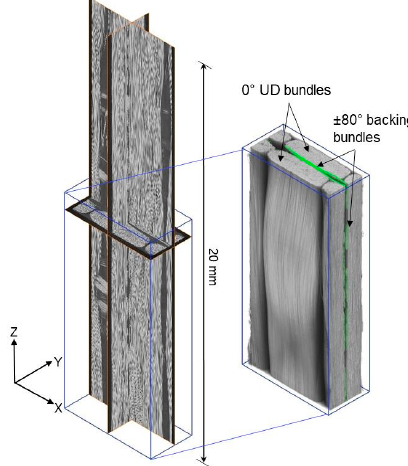
Figure 1. Orthogonal virtual X-ray CT sections ( left ) and a 3D volume rendering ( right ) showing the fibre architecture of the GFRP material where the ±80° backing fibre bundles are rendered in green. Materials 2018 , 11 , x FOR PEER REVIEW